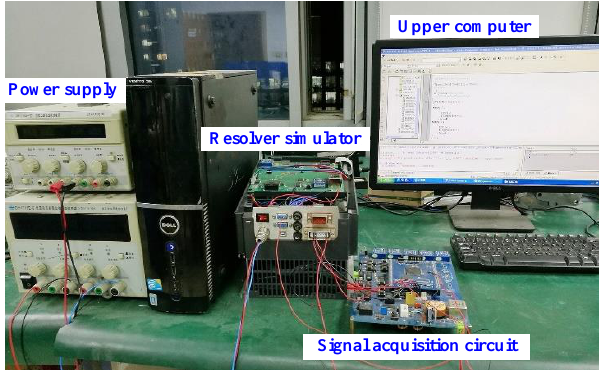
Figure 8. Semi-physical simulation platform.